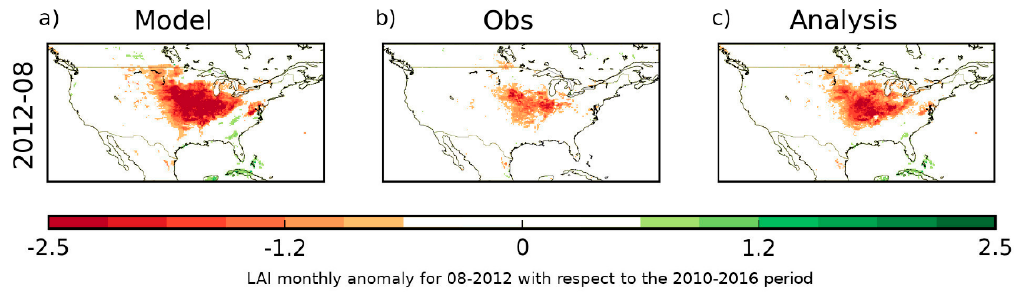
Figure 10. ( a ) Monthly anomaly of leaf area index for August 2012 with respect to the 2010–2016 period, ( b ) same as ( a ) for observed leaf area index, and ( c ) same as ( a ) for analysed leaf area index.